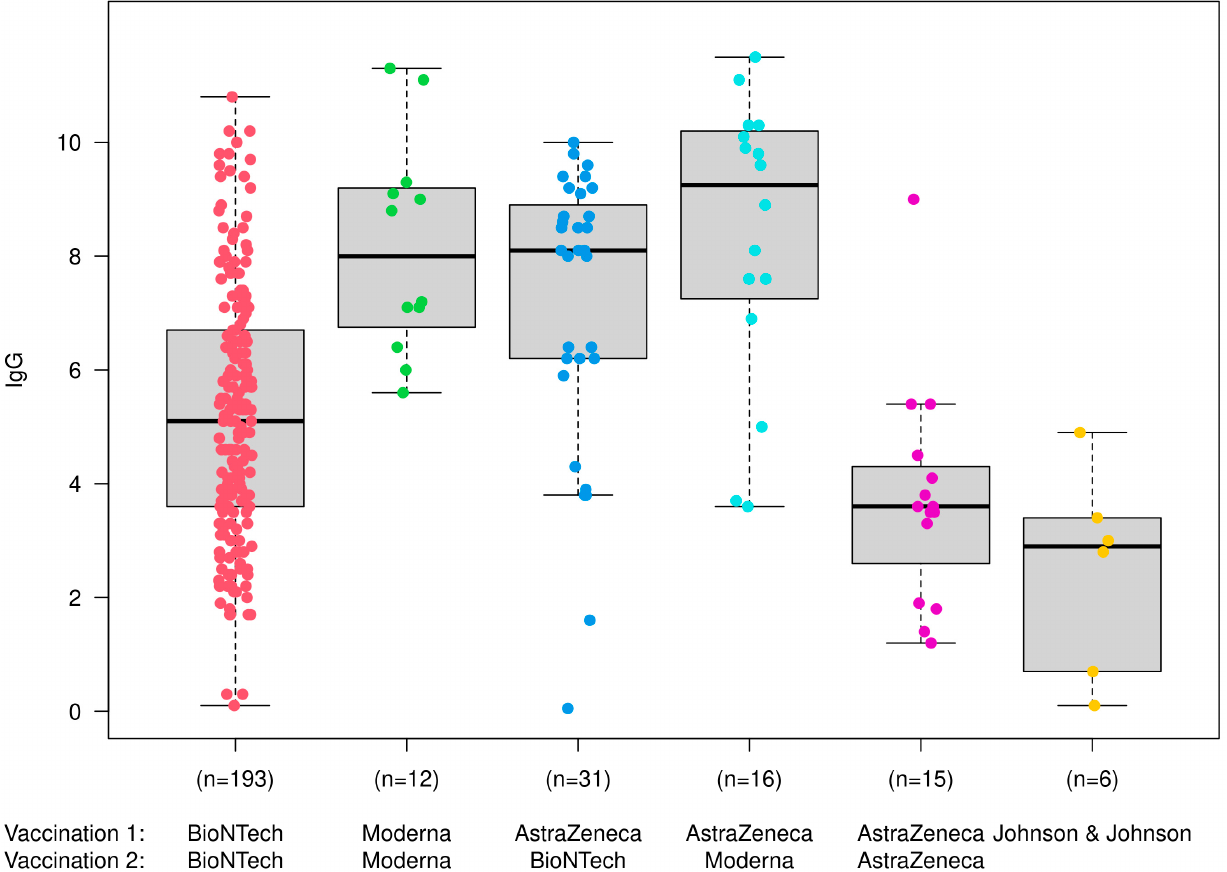
Figure 2. Boxplot of the IgG titres of fully vaccinated study participants at point T3, differentiated by vaccine combination (n = 273).